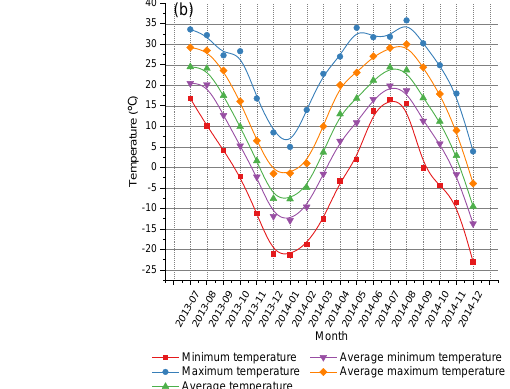
Figure 8. Continuous and intensive dumping in snow season: ( a – c ) dumping in snow season; ( d ) meteorological monitoring station. 4.3. Dynamic Process of Landslides The landslides that occurred on 10 April 2014 are a typical geological disaster in Nanfen open- pit mine. In this study, the SPH method is applied to reproduce the dynamic process of landslides as well as help us to understand the mechanism of large-scale landslide disaster in the waste dump. The computational domain is about 860 × 200 × 300 m, surrounding the potential landslides in the study. The profile of the original valley before dumping generated by SketchUp software is